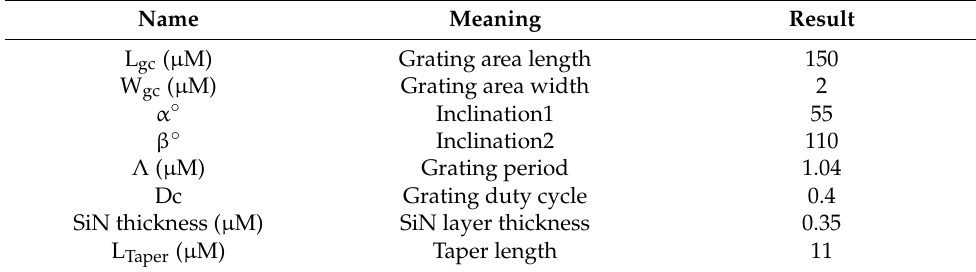
Table 1. Parameters optimization results of the optical antenna.